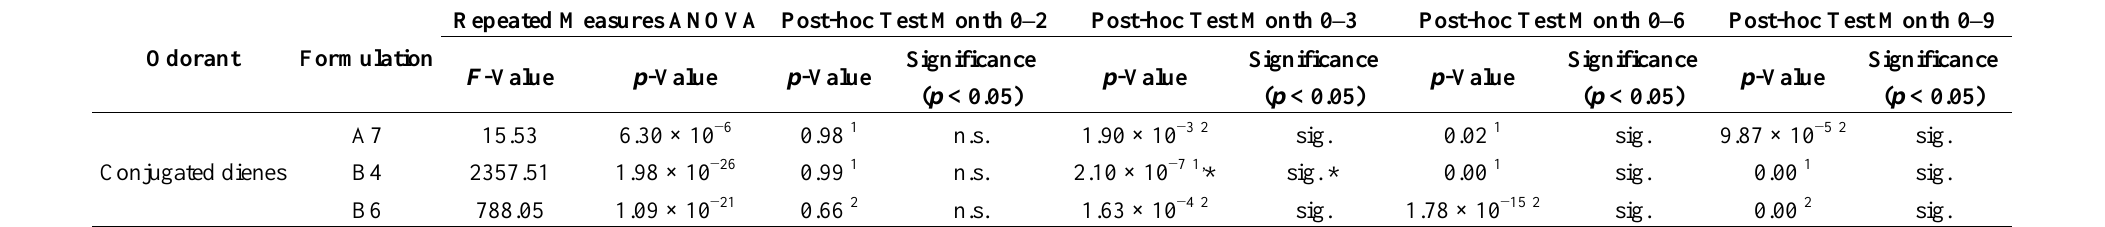
Table 12. Statistical data on one-way repeated ANOVA combined with a post-hoc test 1,2 for pairwise comparison of the means: analysis of lipid oxidation via conjugated dienes over storage